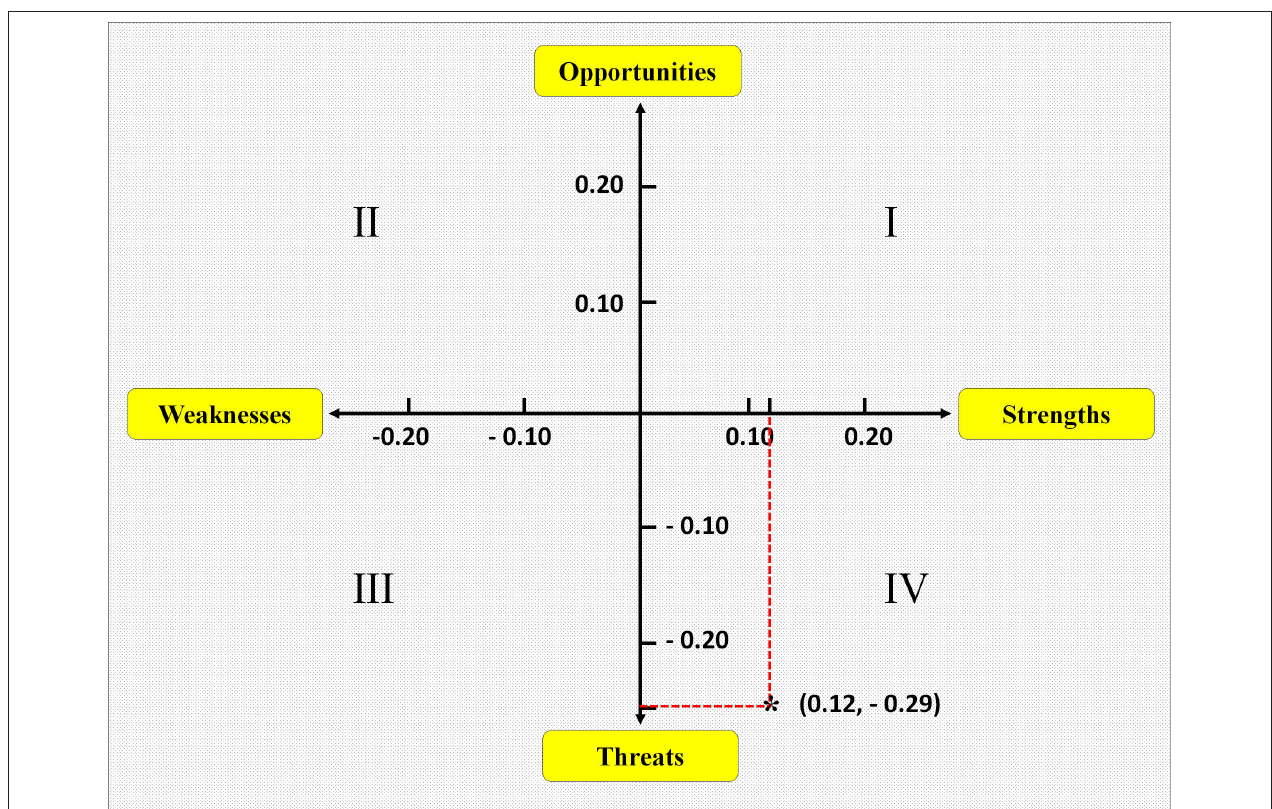
FIGURE 5 | Coordinate points of the condition of Aceh cattle in the Cartesian coordinate